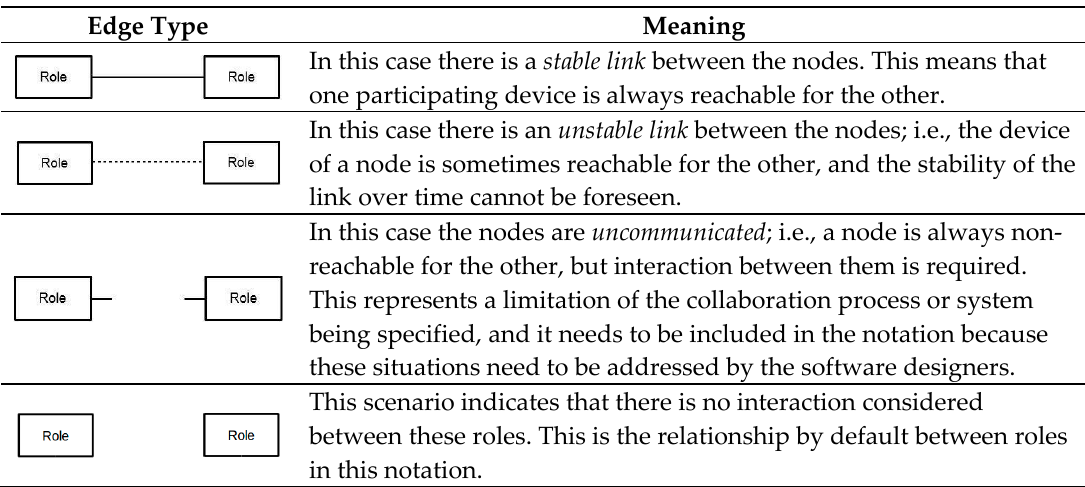
Table 2. Types of edge types supported in CIMoN.